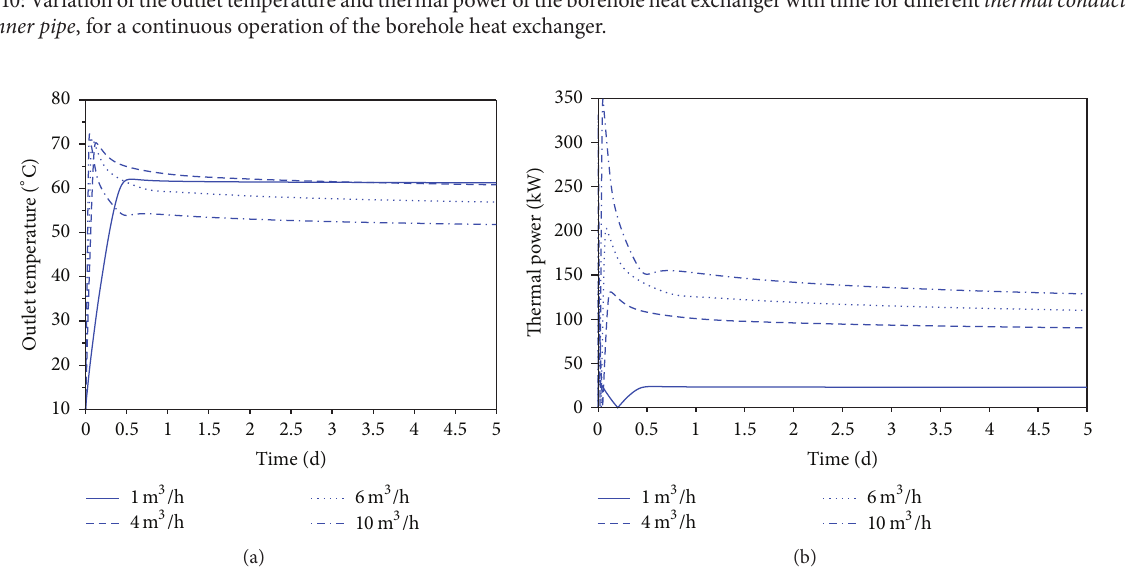
Figure 11: The behaviour of the outlet temperature and thermal power of the Borehole Heat exchanger with time for different flow rates of the circulation water for a continuous